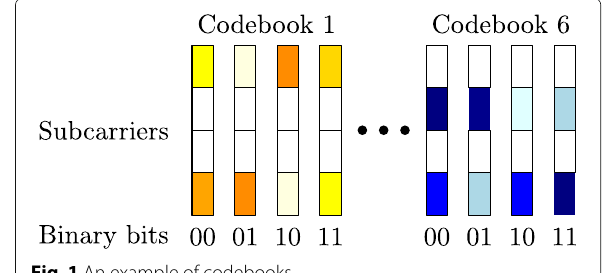
Fig. 1 An example of codebooks